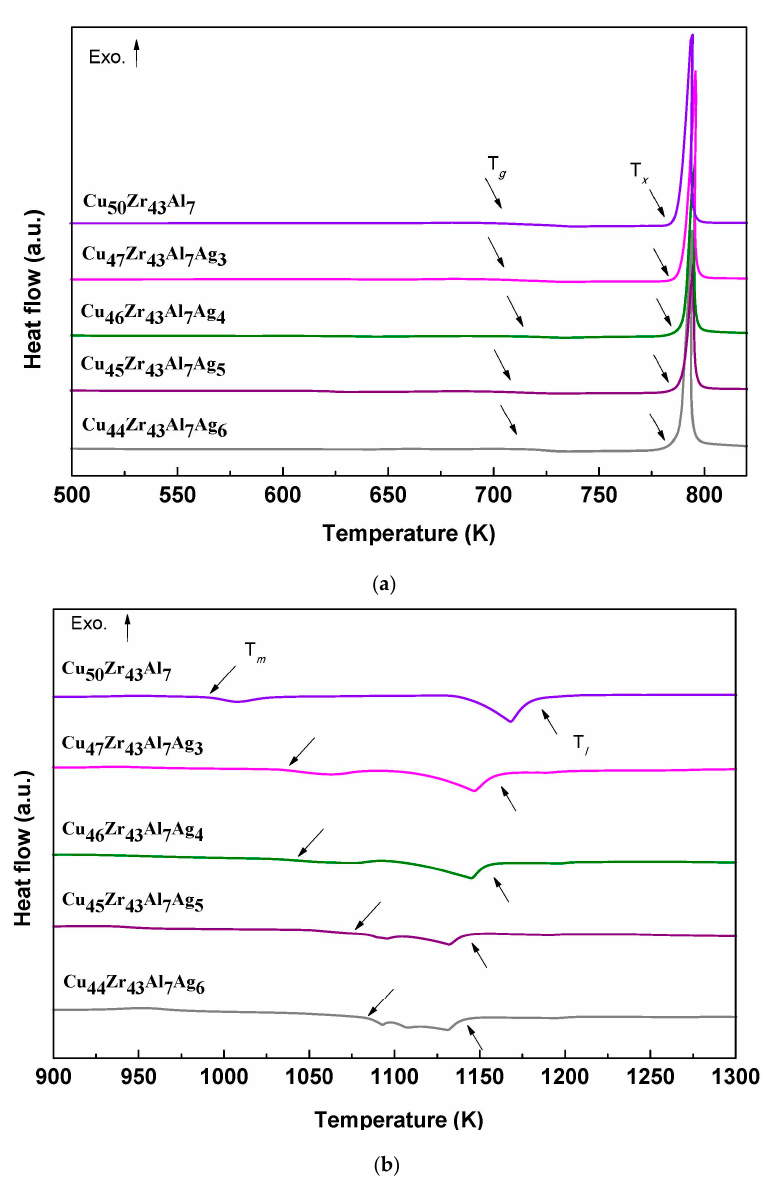
Figure 2. ( a ) The DSC and ( b ) the DTA curves of the Cu 50 − x Zr 43 Al 7 Ag x ( x = 0, 3, 4, 5, 6) BMGs. Table 1. Thermal parameters of the Cu 50 − x Zr 43 Al 7 Ag x ( x = 0, 3, 4, 5, 6) BMG alloys measured at a heating rate of 20 K/min.